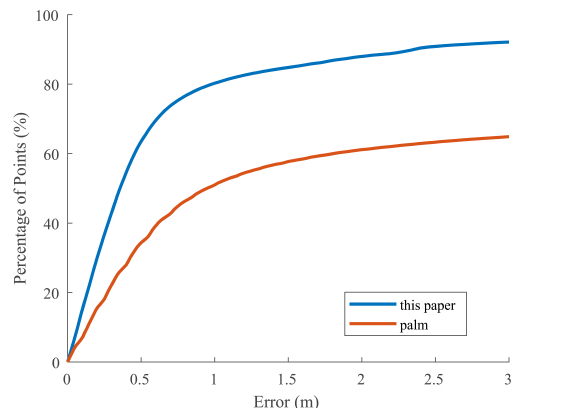
Figure 11. Error curve evaluation. An error curve shows, for a given error distance d , how much of the result falls within d of the ground truth. We can see that our method outperforms Palm12 across all precision